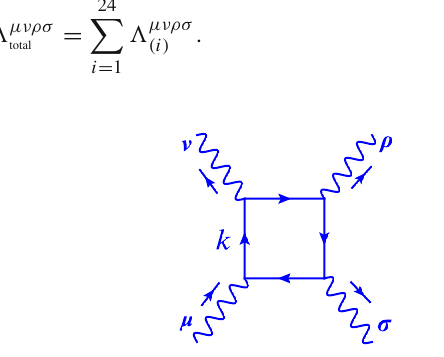
Fig. 1 The box diagram contributing to (cid:7) AAAA